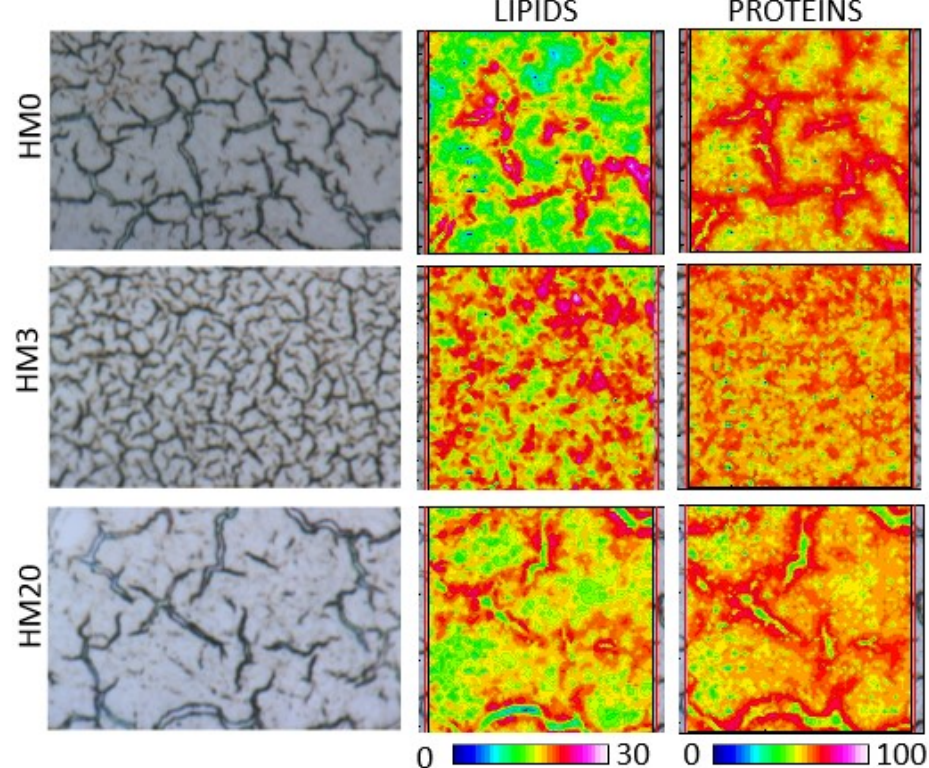
Figure 3. Hyperspectral imaging analysis of representative liver sample of rainbow trout fed the experimental diets. False color images show the topographical distribution of lipids (LIPIDS, 0–30 color scale) and proteins (PROTEINS, 0–100 color scale). Black/dark blue color represents the lowest absorbance values of the infrared radiation, while white/light pink the highest ones.